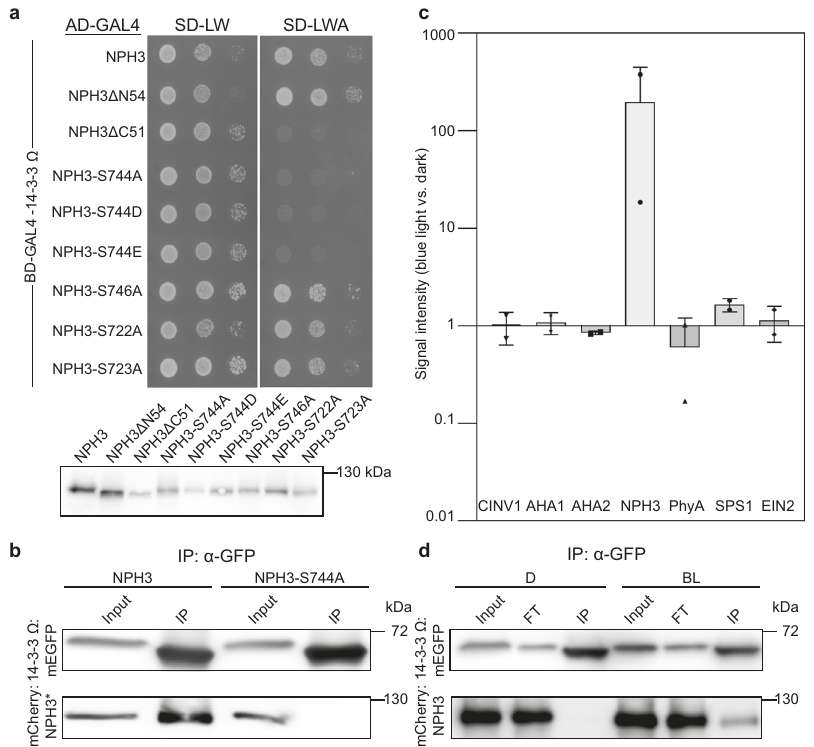
Fig. 3 Interaction of NPH3 and 14-3-3 proteins is triggered by blue light irradiation and abolished by mutation of the third last NPH3 residue. a Yeast two-hybrid interaction analysis of the Arabidopsis 14-3-3 isoform omega with NPH3 variants (upper panel). Expression of the diverse NPH3 fusion proteins was con fi rmed by anti-HA immunoblot of yeast extracts (lower panel). AD, activating domain, BD, binding domain. b In vivo interaction of 14-3-3 omega:mEGFP and either mCherry:NPH3 or mCherry:NPH3-S744A in transiently transformed N. benthamiana leaves. Expression was driven by the 35S promoter. Freshly transformed tobacco plants were kept under constant light for 42 h. The crude extract was immunoprecipitated using GFP beads. Input and immunoprecipitate (IP) were separated on 11% SDS-PAGE gels, followed by immunoblotting with anti-GFP and anti-RFP antibodies, respectively. c Arabidopsis 14-3-3 epsilon interactors were identi fi ed by mass spectrometry analysis of anti-GFP immunoprecipitations from etiolated seedlings expressing 14-3-3 epsilon:GFP and either maintained in darkness or irradiated with blue light (BL) (1 μ mol m − 2 s − 1 ) for 30 min (two biological replicates). Expression was driven by the native promoter. Protein intensities of 14-3-3 client proteins were normalized to relative abundance of the bait protein (Supplementary Table 1). Fold changes in relative abundance (mean ± SD, logarithmic scale) of blue light treatment vs. darkness are given. AHA1, AHA2, Arabidopsis H + -ATPase; CINV1, cytosolic invertase 1; EIN2, ethylene insensitive 2; PhyA, phytochrome A; SPS1, sucrose phosphate synthase 1. d In vivo interaction of 14-3-3 omega:mEGFP and mCherry:NPH3 in transiently transformed N. benthamiana leaves. Expression was driven by the 35S promoter. Dark-adapted tobacco plants were either kept in darkness (D) or treated with BL (10 μ mol m − 2 s − 1 ) for 40 min. The crude extract was immunoprecipitated using GFP beads. Input, fl owthrough (FT) and IP were separated on 11% SDS-PAGE gels, followed by immunoblotting with anti-GFP and anti-RFP antibodies, respectively. Experiments in a , b , and d were performed at least three times with similar